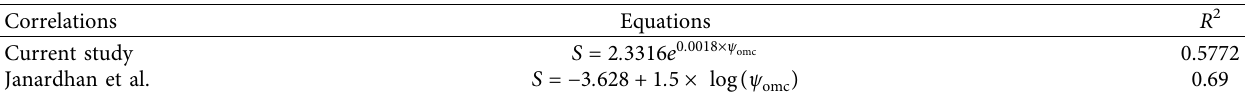
Table 10: The regression equation (models) considered in the validation process.